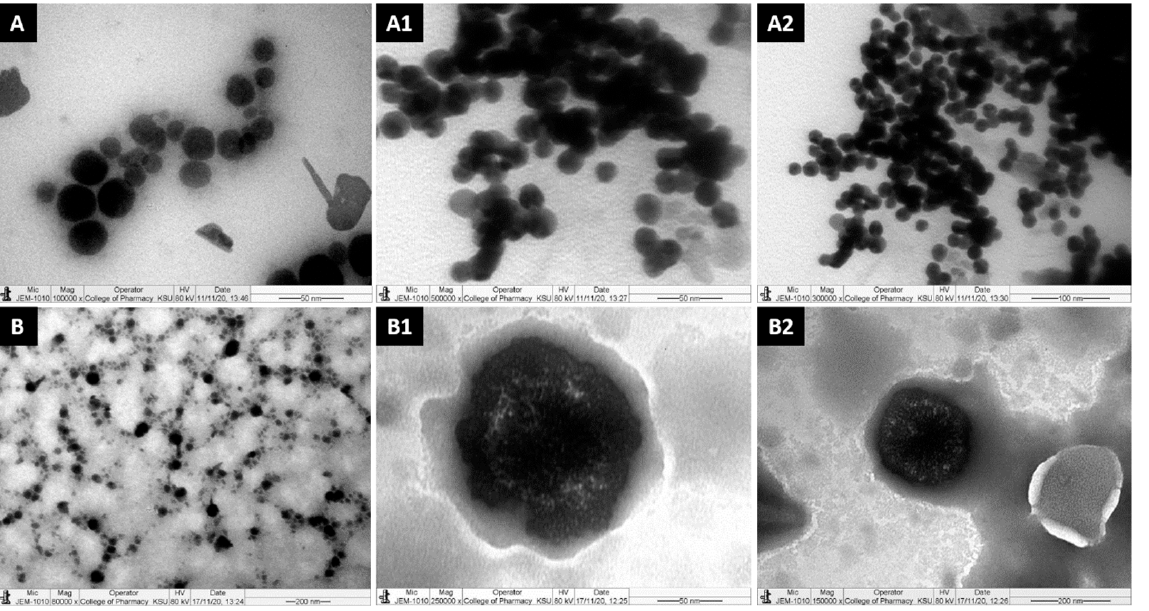
Figure 4. TEM micrographs of propofol - loaded representative formulations. ( A , A1 , A2 ) represent images of the droplet sizes of the PF2-SNEDDS at a 50–100 nm scale, and ( B , B1 , B2 ) represent images of the droplet sizes of the PF8-SNEDDS at a 50–200 nm scale.